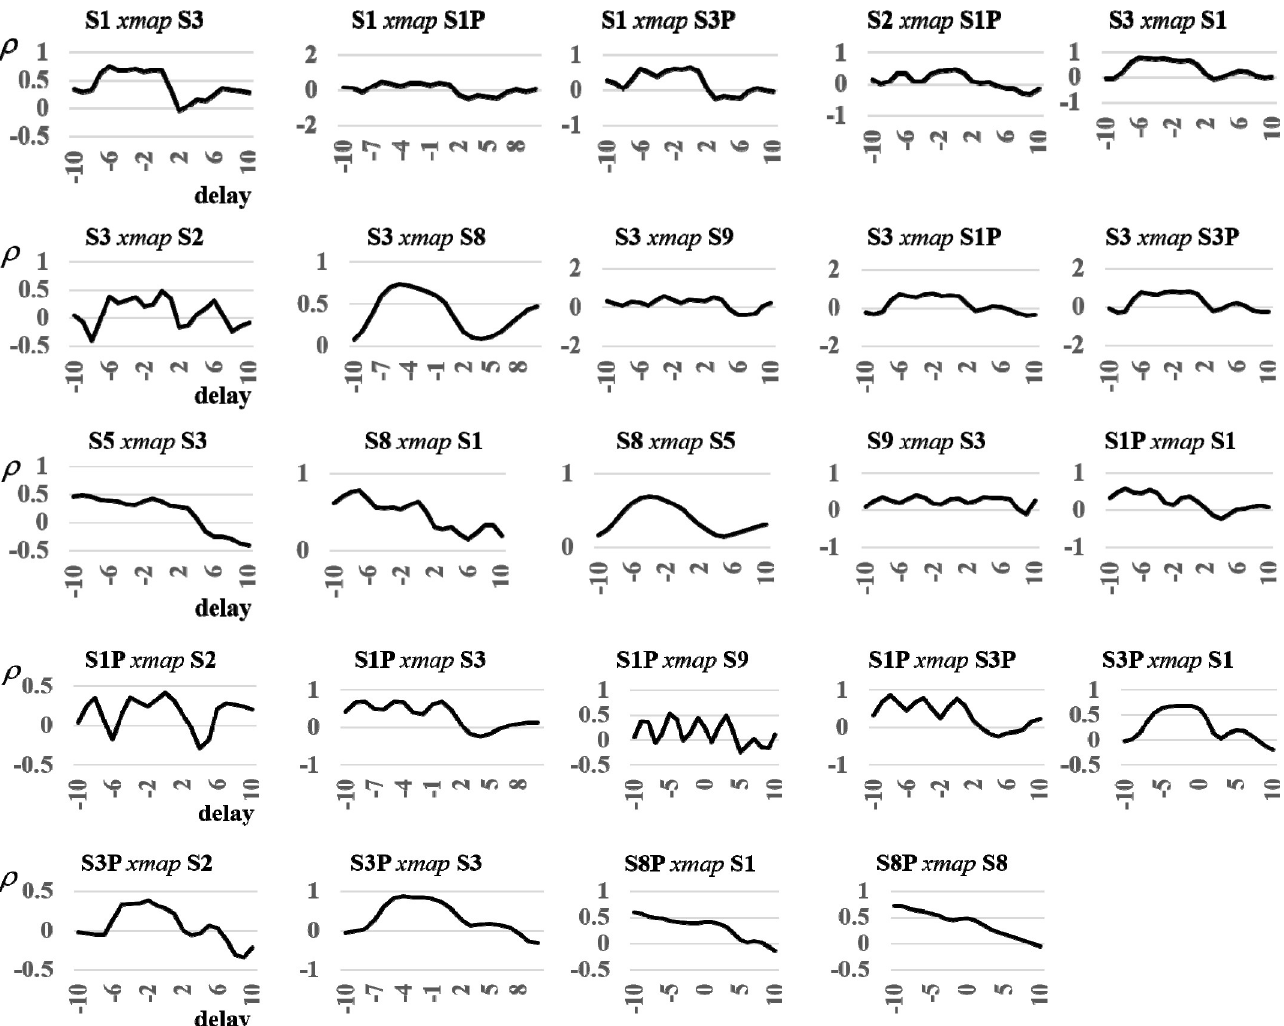
Fig 12. Delayed (Extended) CCM results. We screened for interactions whose cross mappings pass delayed (extended) CCM tests to rule out non-causal synchronous behavior, as demonstrated by delayed CCM curves with peaks at nonpositive delays in the figure.